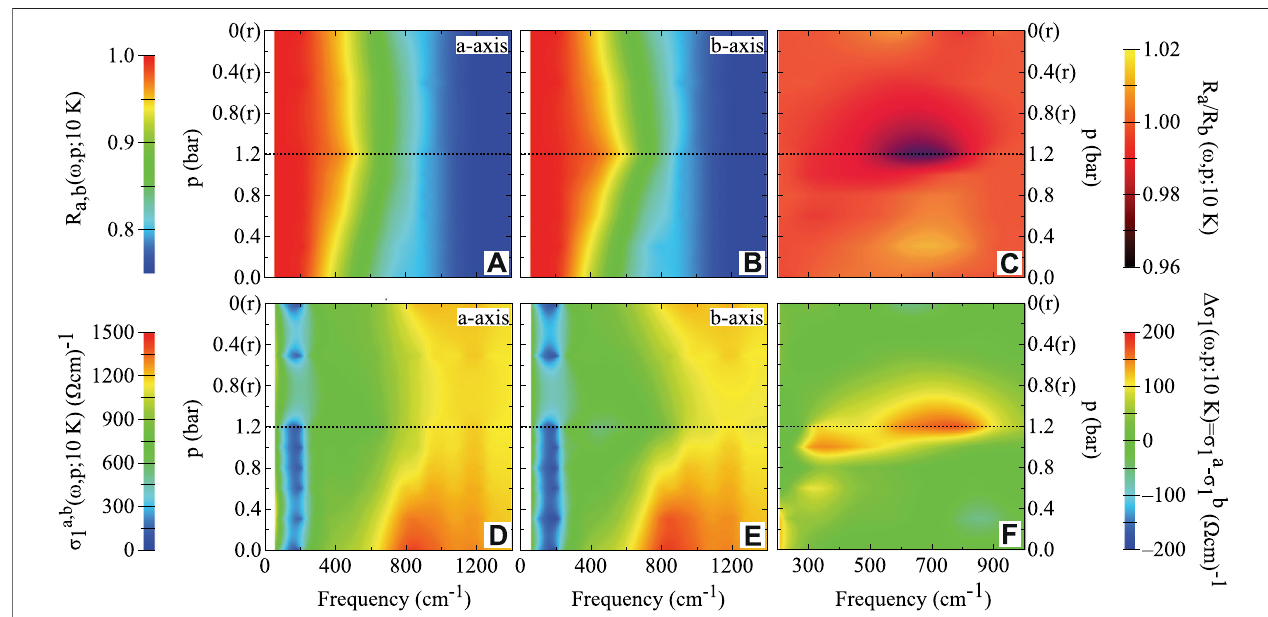
FIGURE 7 | (color online) (A,B) Representative data of the optical re fl ectivity ( R ( ω )) of Ba 0.6 K 0.4 Fe 2 As 2 at 10 K for the p -loop experiment after a ZPC protocol along the a - and b -axis ( R a and R b , respectively, upper-left panel of Figure 2 ) in the spectral range below 1,400 cm − 1 . (C) The re fl ectivity ratio R Ratio = R a / R b . (D,E) Real part σ ω ) of the optical conductivity, achieved through KK transformation of the data in panels (A,B) . (F) The dichroism Δ σ 1 ( experiment. Panels (C,F) focus the attention to the FIR energy interval 200 – 1,000 cm − 1 , where the reversible optical anisotropy upon sweeping p is discovered. A fi rst-neighbor interpolation procedure is used in order to generate the color maps. Released p is denoted by “ (r) ” . The thick dotted line in all panels marks p = 1.2 bar (i.e., at saturation). Reproduced from Ref. [27].